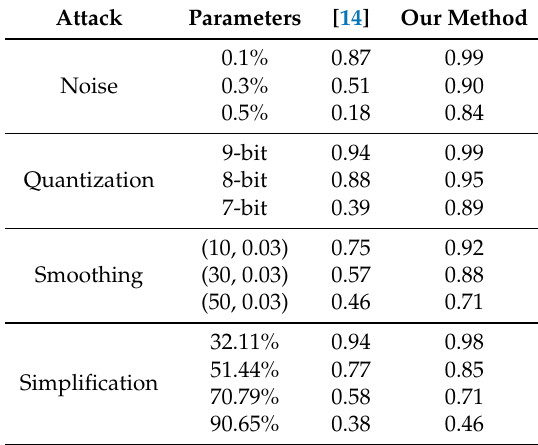
Table 21. Results of robustness comparison with Cho et al.’s [14] method measured in terms of NC for the Bunny model.